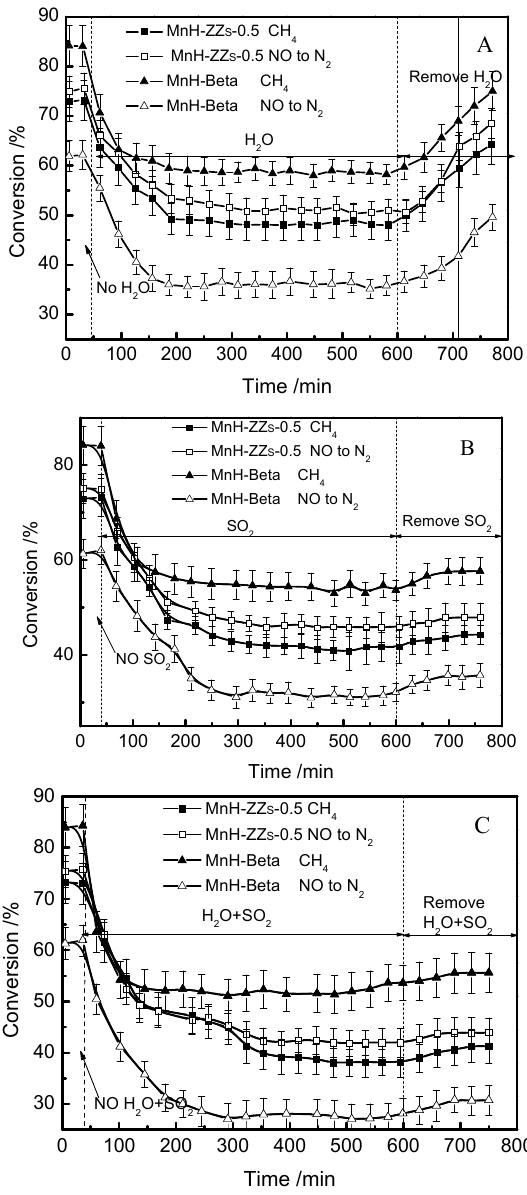
Figure 4. E ff ect of ( A ) water vapor, ( B ) SO 2 and ( C ) H 2 O + SO 2 on the CH 4 -SCR activity over MnH-ZZs-0.5 and MnH-Beta. Reaction condition: NO 2180 ppm, CH 4 2050 ppm, O 2 2%, H 2 O 2% / SO 2 78 ppm GHSV 7500 h − .